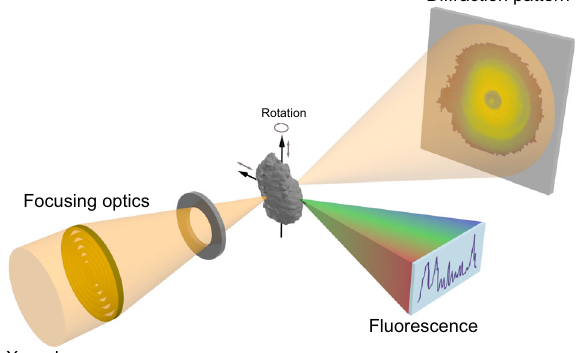
Fig. 1 Schematic illustration of using the Hard X-ray Nanoprobe (HXN) beamline of NSLS-II for multimodal measurements. While the sample is raster-scanned by a nano-focused X-ray beam, both X-ray fl uorescence images and transmitted coherent diffraction signals are collected simultaneously. A series of XRF maps and phase-contrast ptychographic images are collected while the sample is rotated in the beam to obtain 3D images. At the HXN beamline, the X-ray beam can be focused by an FZP or MLLs. The central beamstop is not shown to simplify the